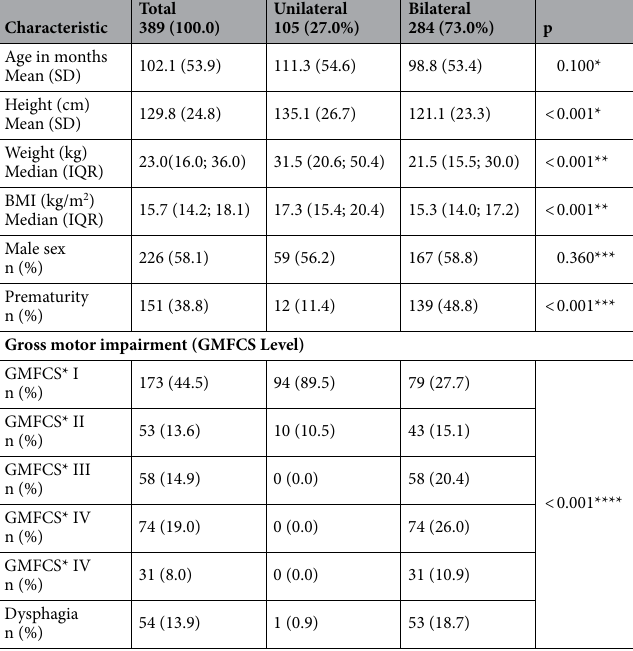
Table 1. Characteristics of the study population at the last visit by unilateral and bilateral cerebral palsy subgroup. GMFCS Gross Motor Function Classification System. *t-test, **Mann–Whitney- U test. ***Fisher’s exact test. ****Kruskal–Wallis